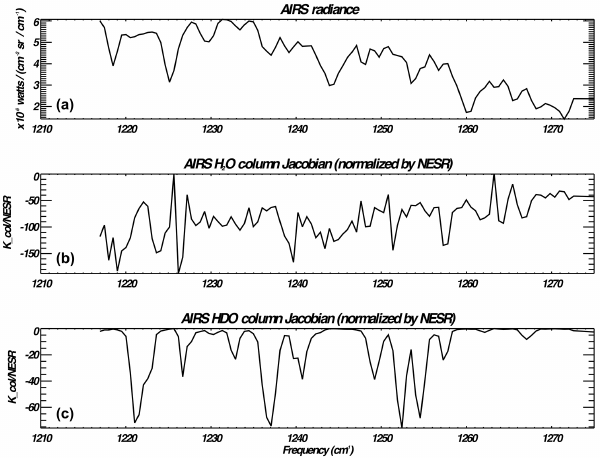
Figure 1. (a) AIRS radiance at approximately 8µm for a typical tropical scene. (b) The total column (log) Jacobian for H 2 O nor- malized by the AIRS NESR. (c) The total column (log) Jacobian for HDO normalized by the AIRS